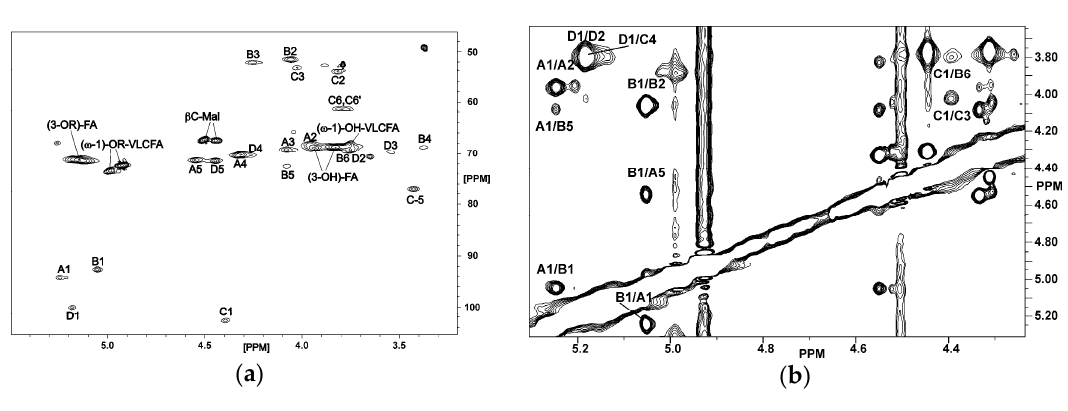
Figure 2. Part of the HSQC ( a ) and 1 H- 1 H ROESY ( b ) spectra of lipid A from O. carboxidovorans OM5. Only signals important for structural analysis are marked. Table 2. 1 H and 13 C NMR chemical shifts [ δ ; ppm] of the O. carboxidovorans OM5 lipid A backbone.